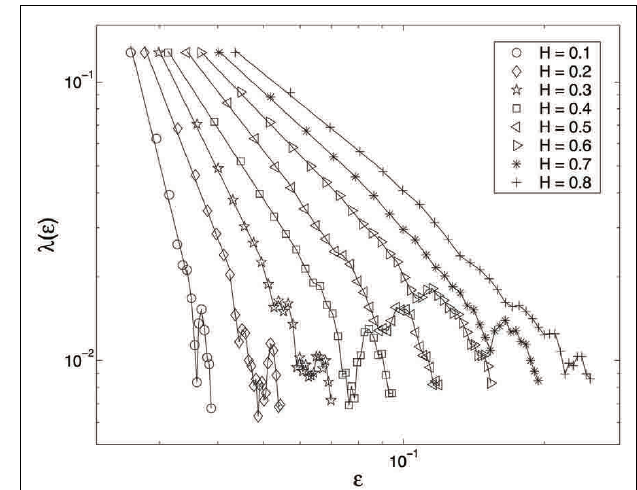
FIGURE 5 | (A) An intermittent time series generated by the logistic map with a = 3.8284. (B) The SDLE curve for a time series of 10000 points, with m = 4, L = 1, and a shell size of (2 − 13.5 , 2 − 13 ). A plateau, indicated by arrow A, is clearly visible. Regions indicated by arrows B and C are due to transitions between periodic and chaotic motions, and arrow D indicates the region of oscillatory motions.